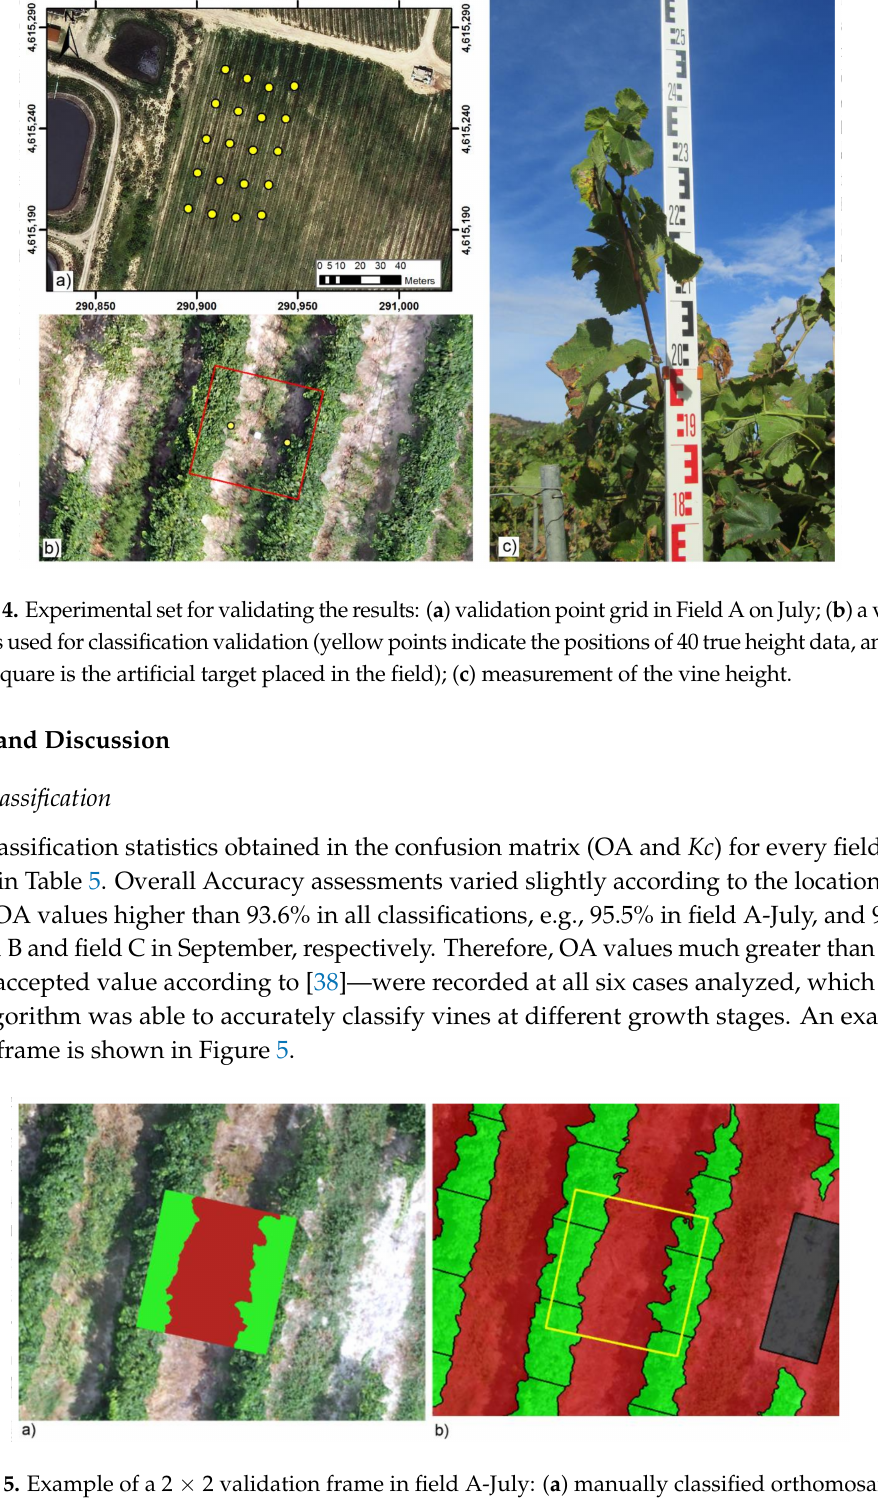
Figure 5. Example of a 2 × 2 validation frame in field A-July: ( a ) manually classified orthomosaicked image (R-G-B composition); ( b ) DSM-OBIA-based